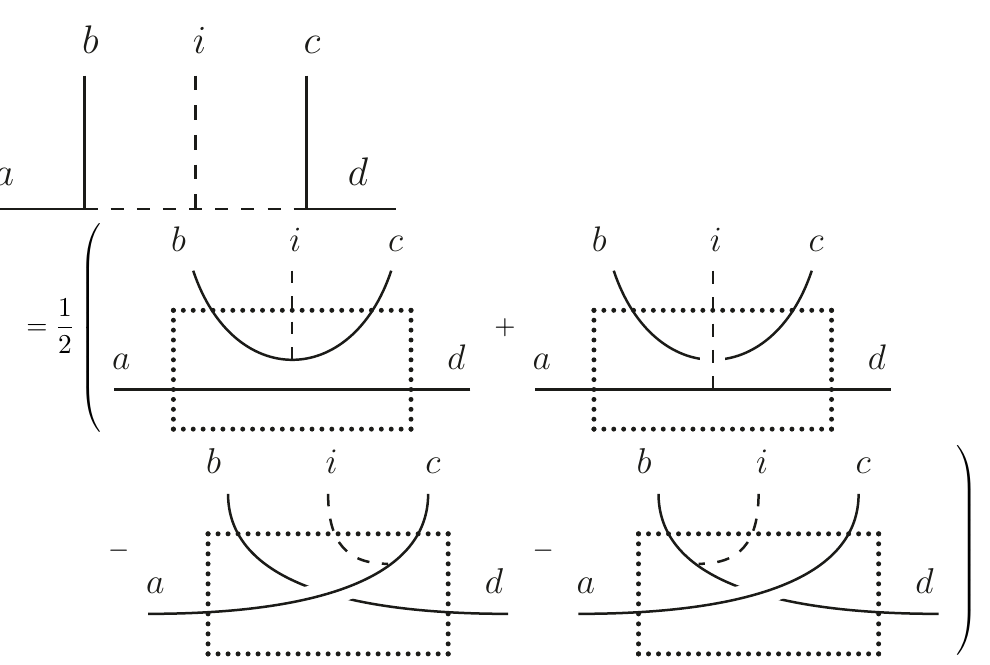
Figure 15 . Graphical representation of eq. (A.3). Only the first term on the r.h.s. generates δ ad .